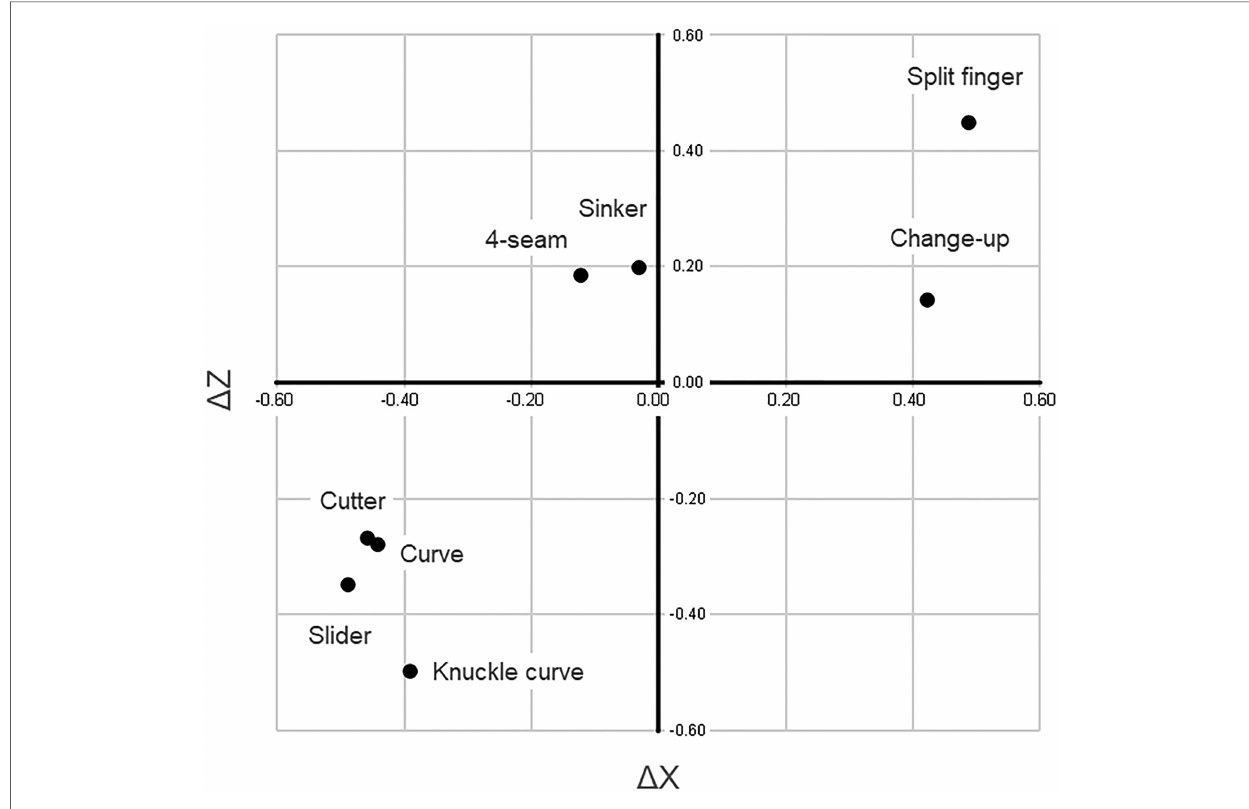
FIGURE 4 Relationship between spin rate and Δ X and between spin rate and Δ Z, as shown by correlation coef fi